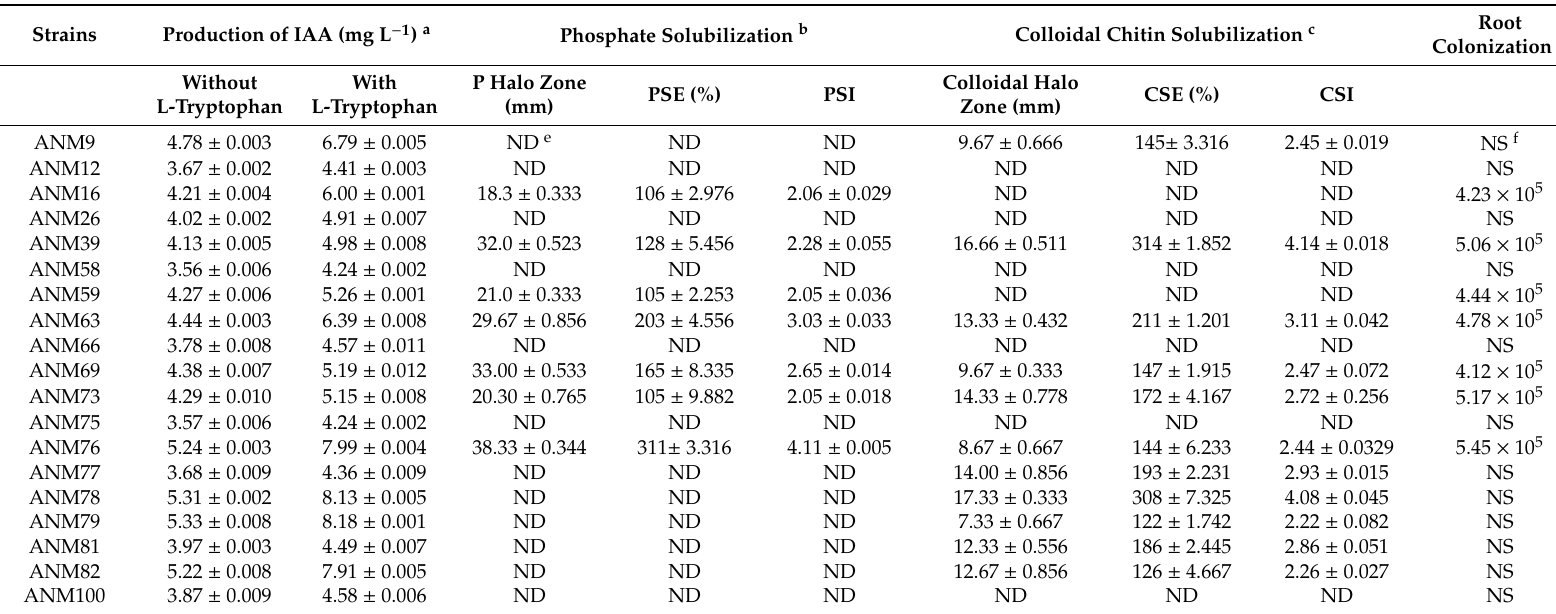
Table 1. Plant growth promoting characteristics in terms of production of indole-3-acetic acid (IAA), phosphate solubilization, colloidal chitin solubilization and root colonization ability by tested endophytic strains from